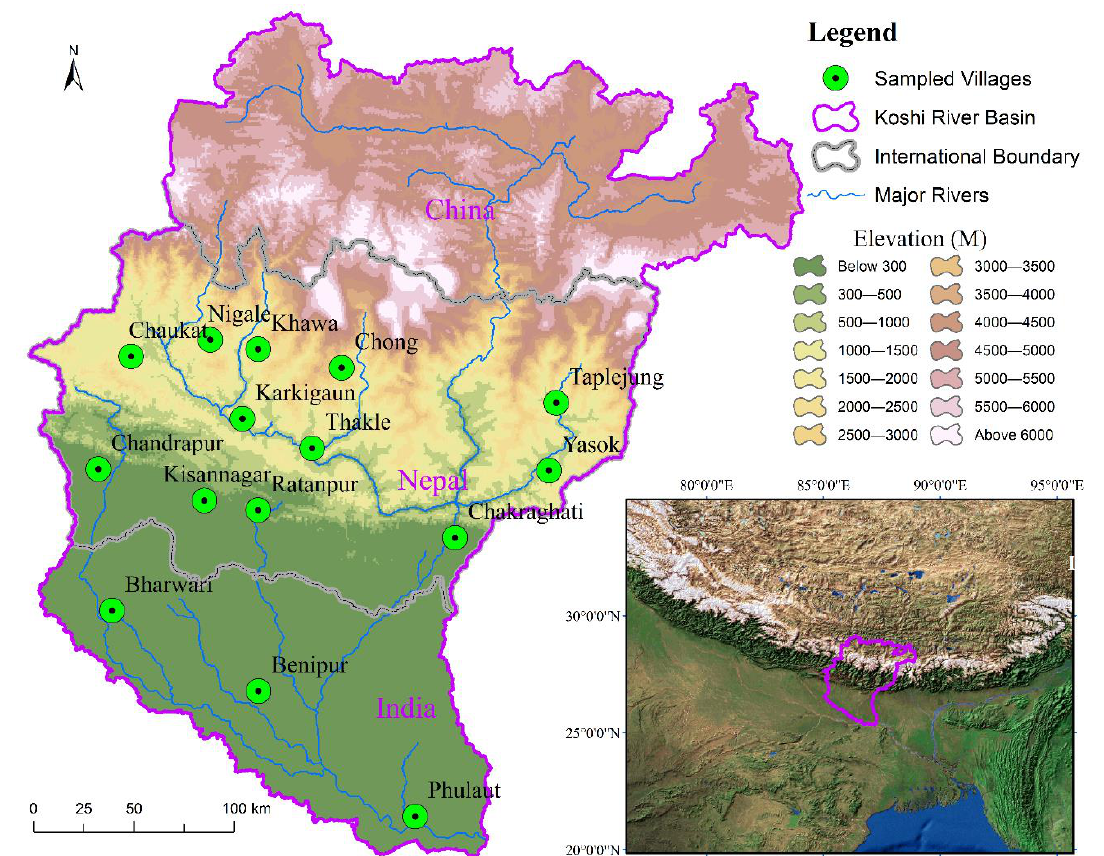
Figure 1. Map showing the sampled villages in the study.